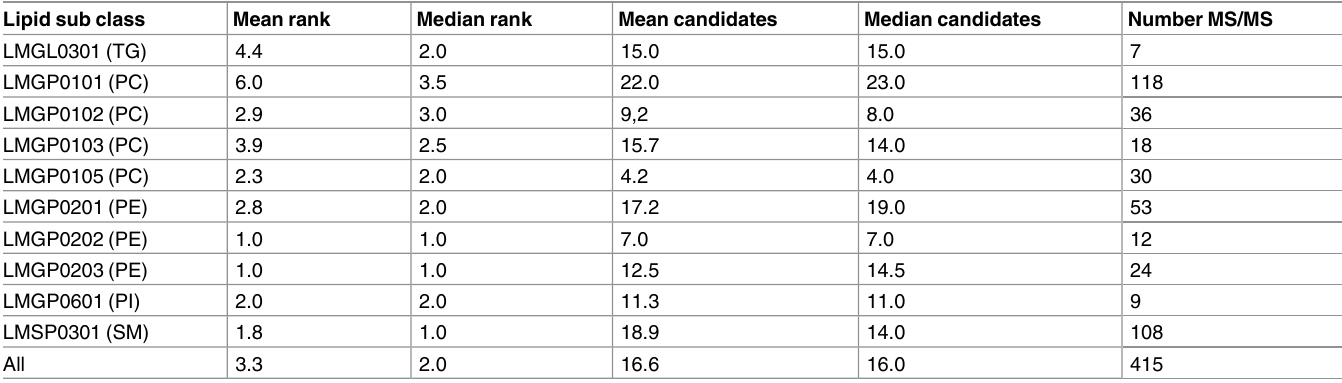
Table 2. LipidFrag rankings on the 415 Bio-MassBank spectra.